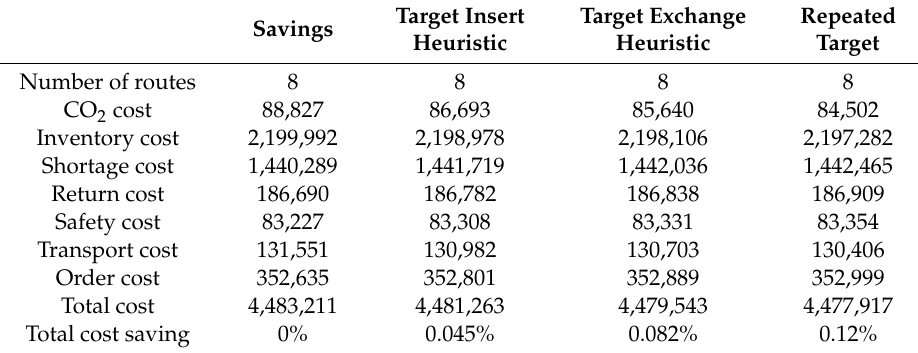
Table 11. The simulated numerical results for PRIRPSDRCO 2 .